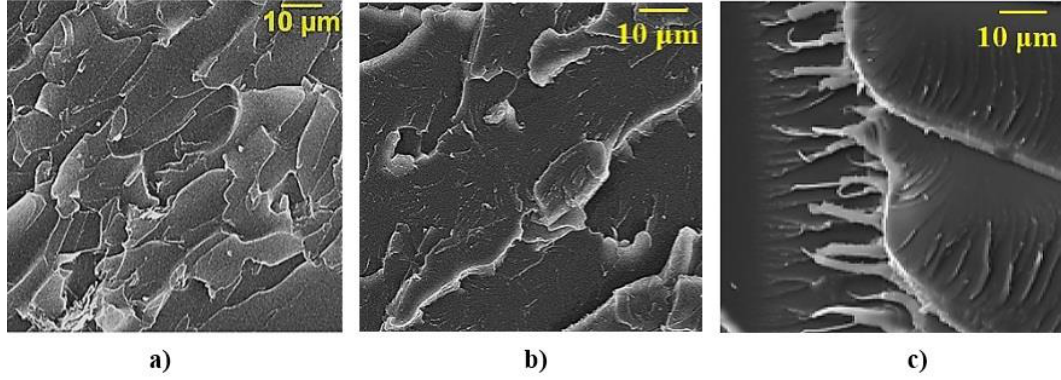
Figure 9. Physico-mechanical characteristics of epoxy composites: 1—epoxy composite, without filler and microwave modification; 2—epoxy composite with 0.1 parts by mass of ocher relative to ED-20, without microwave modification of composition; 3—epoxy composite with 0.1 parts by mass of ocher relative to ED-20, and after microwave modification of composition.